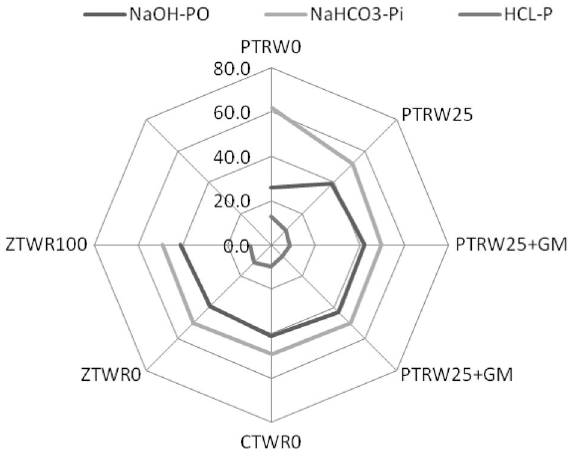
Figure 10. Contribution (%) of selected indicators to soil quality under rice and wheat treatments. PTR WS0 - puddled transplanted rice with no wheat straw, PTR W25 -puddled transplanted rice with 25% anchored wheat straw retained, GM-Green manure, CTW R0 -conventional tillage wheat with rice straw removed, ZTW R0 -zero tillage wheat with rice straw removed, ZTW R100 -ZTW with 100% rice straw retained as surface